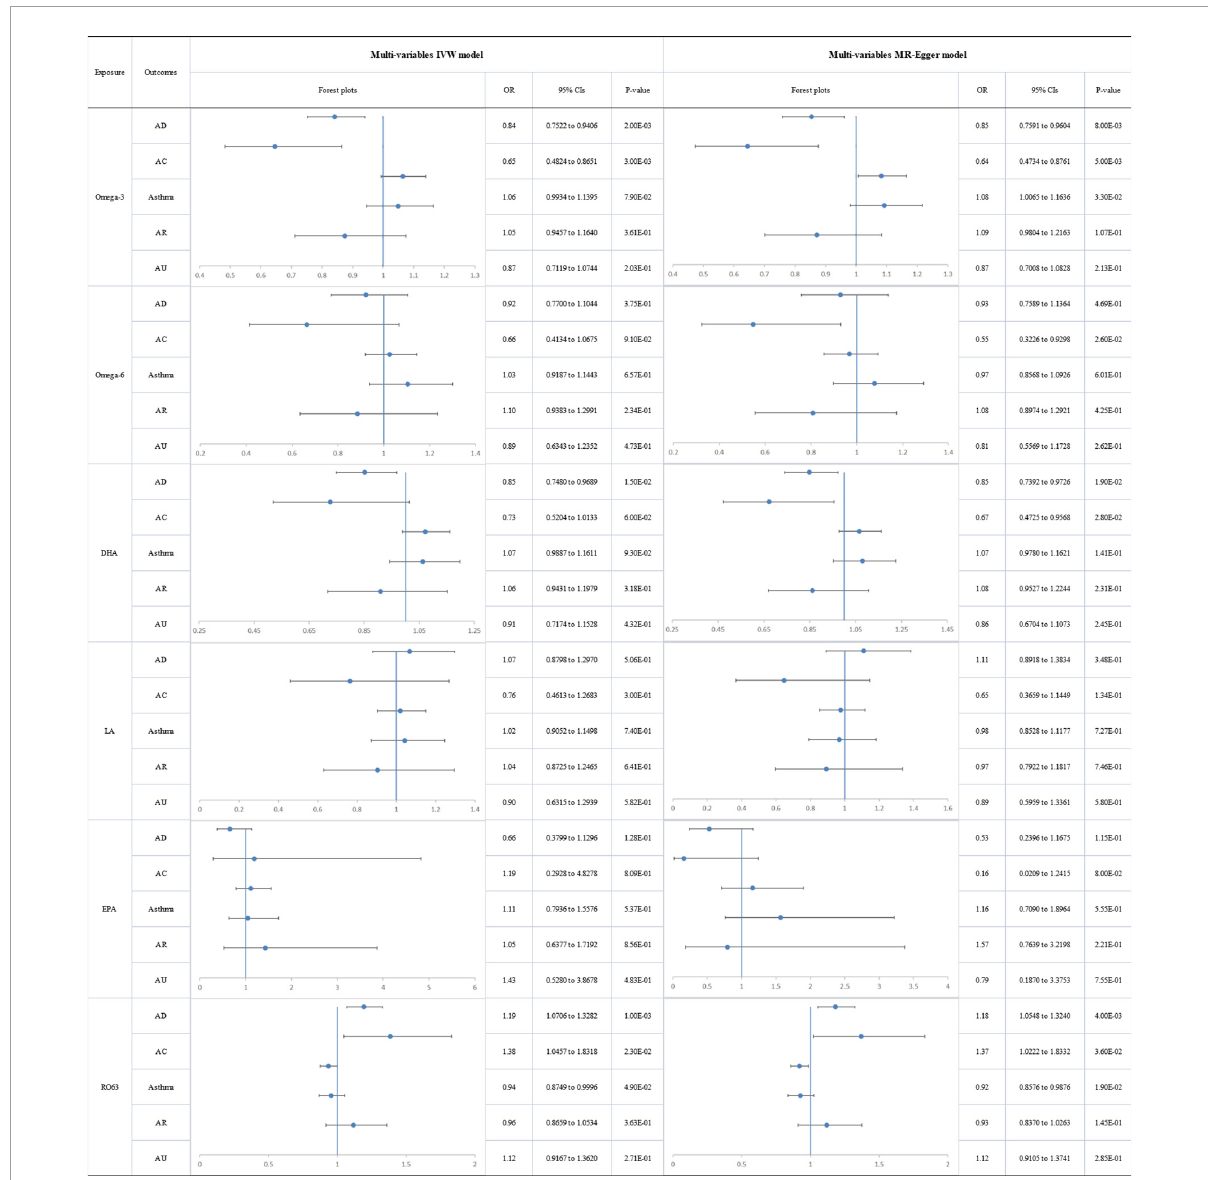
FIGURE6 The forest plot of the multivariable Mendelian randomization exploring the associations between genetically determined polyunsaturated fatty acids and allergic diseases adjusted for confounding traits (body mass index, smoking, alcohol intake, age, and income level) OR: odds ratio; CIs: confidence intervals; Omega-3: omega-3 fatty acids; Omega-6: omega-6 fatty acids; DHA: docosahexaenoic acid; LA: linoleic acid; EPA: eicosapentaenoic acid; RO63: ratio of omega-6 fatty acids to omega-3 fatty acids; AD: atopic dermatitis; AC: Atopic conjunctivitis; AR: Allergic rhinitis; AU: Allergic